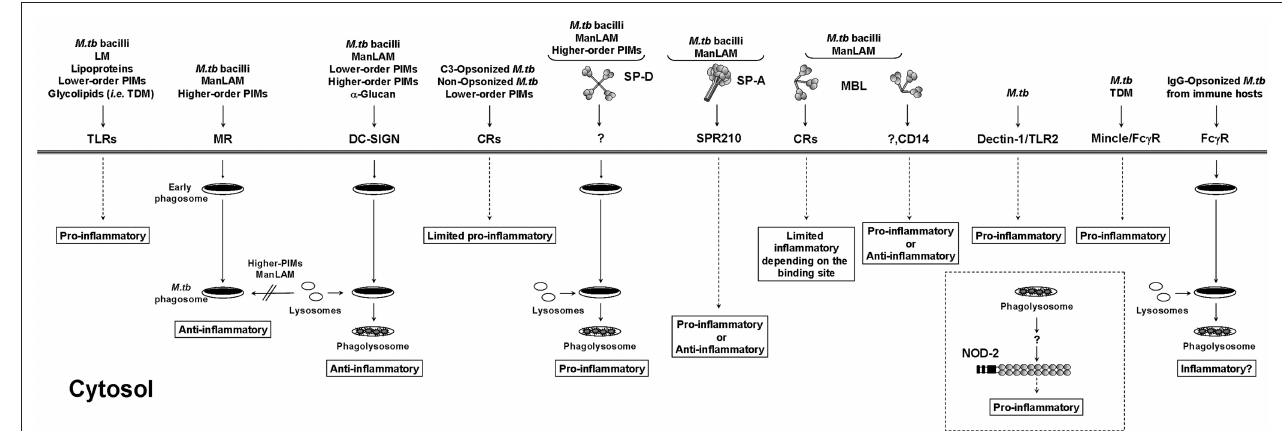
Toll-like receptor; MR, mannose receptor; DC-SIGN, dendritic cell-specific intercellular adhesion molecule-3 grabbing non-integrin; CR, complement receptor; SP-A and SP-D, surfactant protein-A and -D; MBL, mannose binding lectin; Dectin-1, dendritic cell-associated C-type lectin-1; Mincle, macrophage-inducible C-type lectin; NOD-2, nucleotide-binding oligomerization domain-like receptor